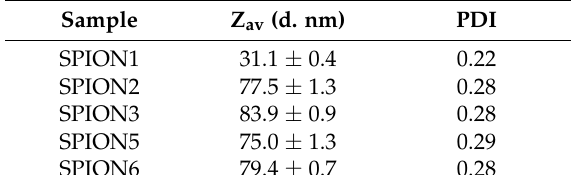
Table 2. Zeta average (Z av ) and polydispersity index (PDI) of nanosystems, superparamagnetic iron oxide nanoparticle (SPION) 1–5.